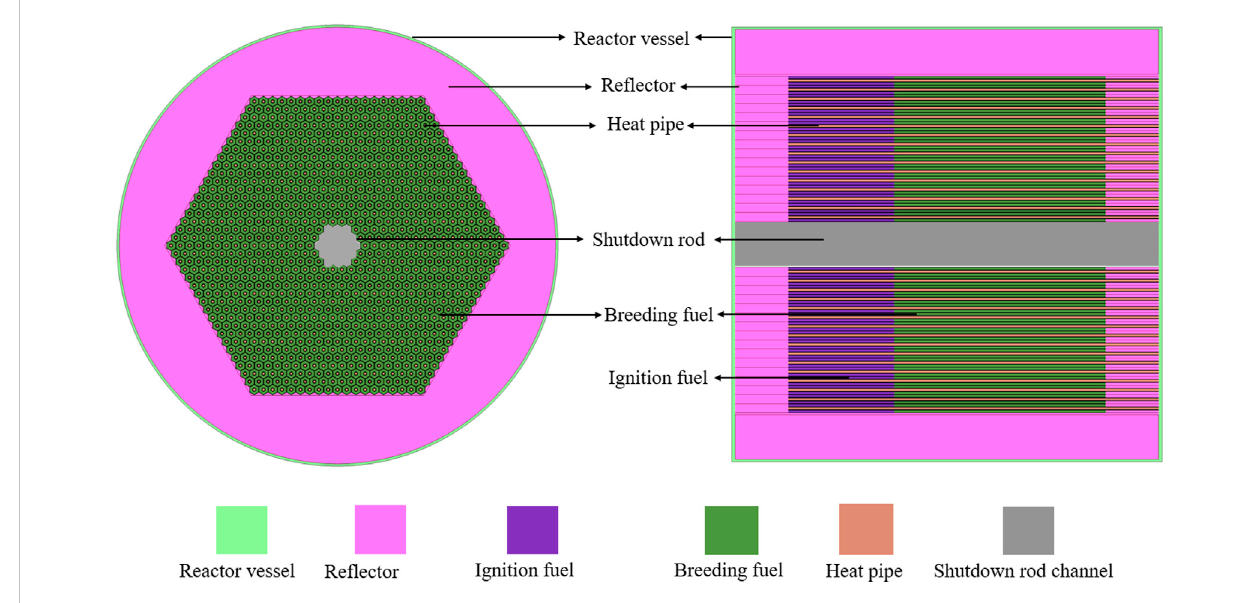
FIGURE 3 Cross-section view and longitudinal cross-section view of the HPTWR.